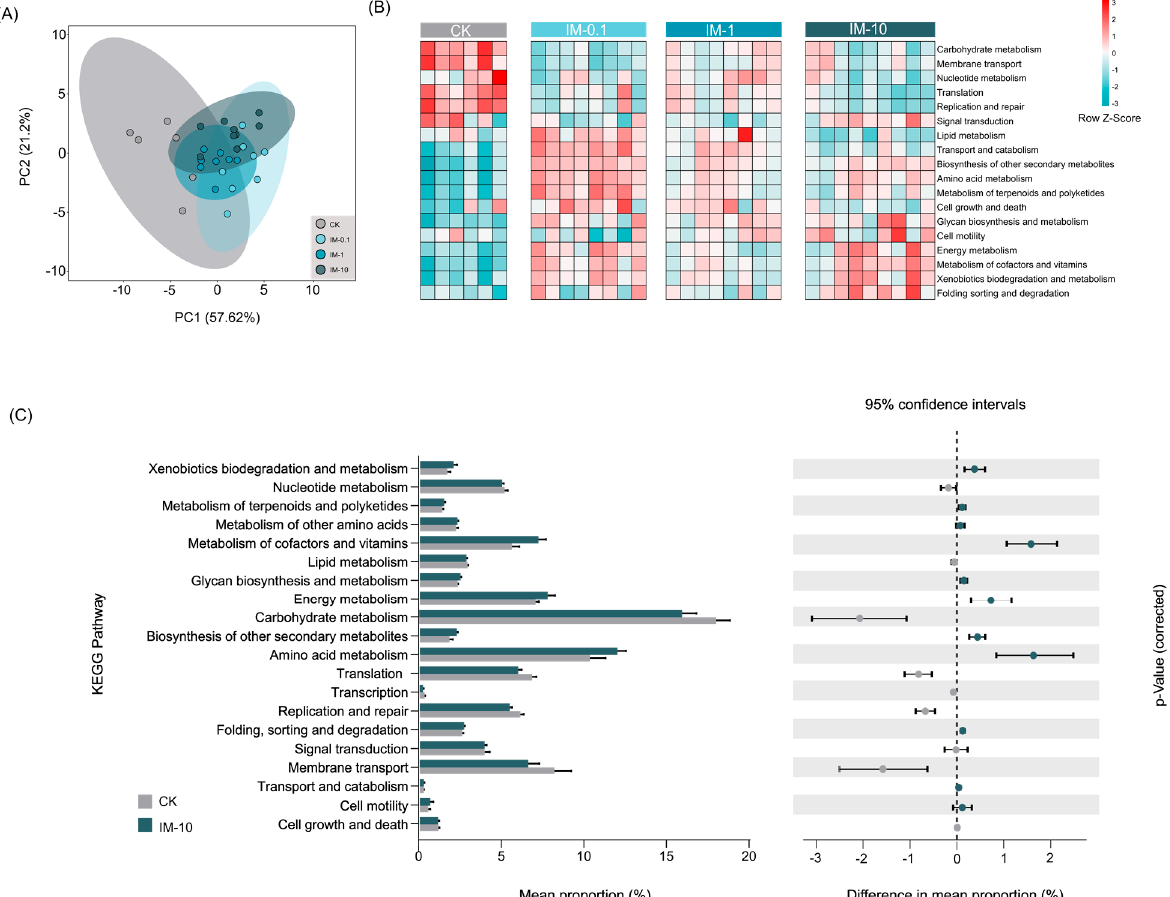
Figure 5. Functional profiles of the gut microbiota between CK and imidacloprid treated bumblebees. ( A ) PCoA plot describing functional inferences (PICRUSt) of bacterial communities across imidacloprid treatments. ( B ) Heatmap displaying the differentially enriched KEGG pathways (Level 2) prediction by PICRUSt across different concentration treatment groups. ( C ) Bar plots showing the relative abundance of KEGG pathways prediction by PICRUSt and the difference between CK and IM-10. CK, IM-0.1, IM-1 and IM-10 represent control, 0.1, 1, and 10 μ g/L imidacloprid treatment.